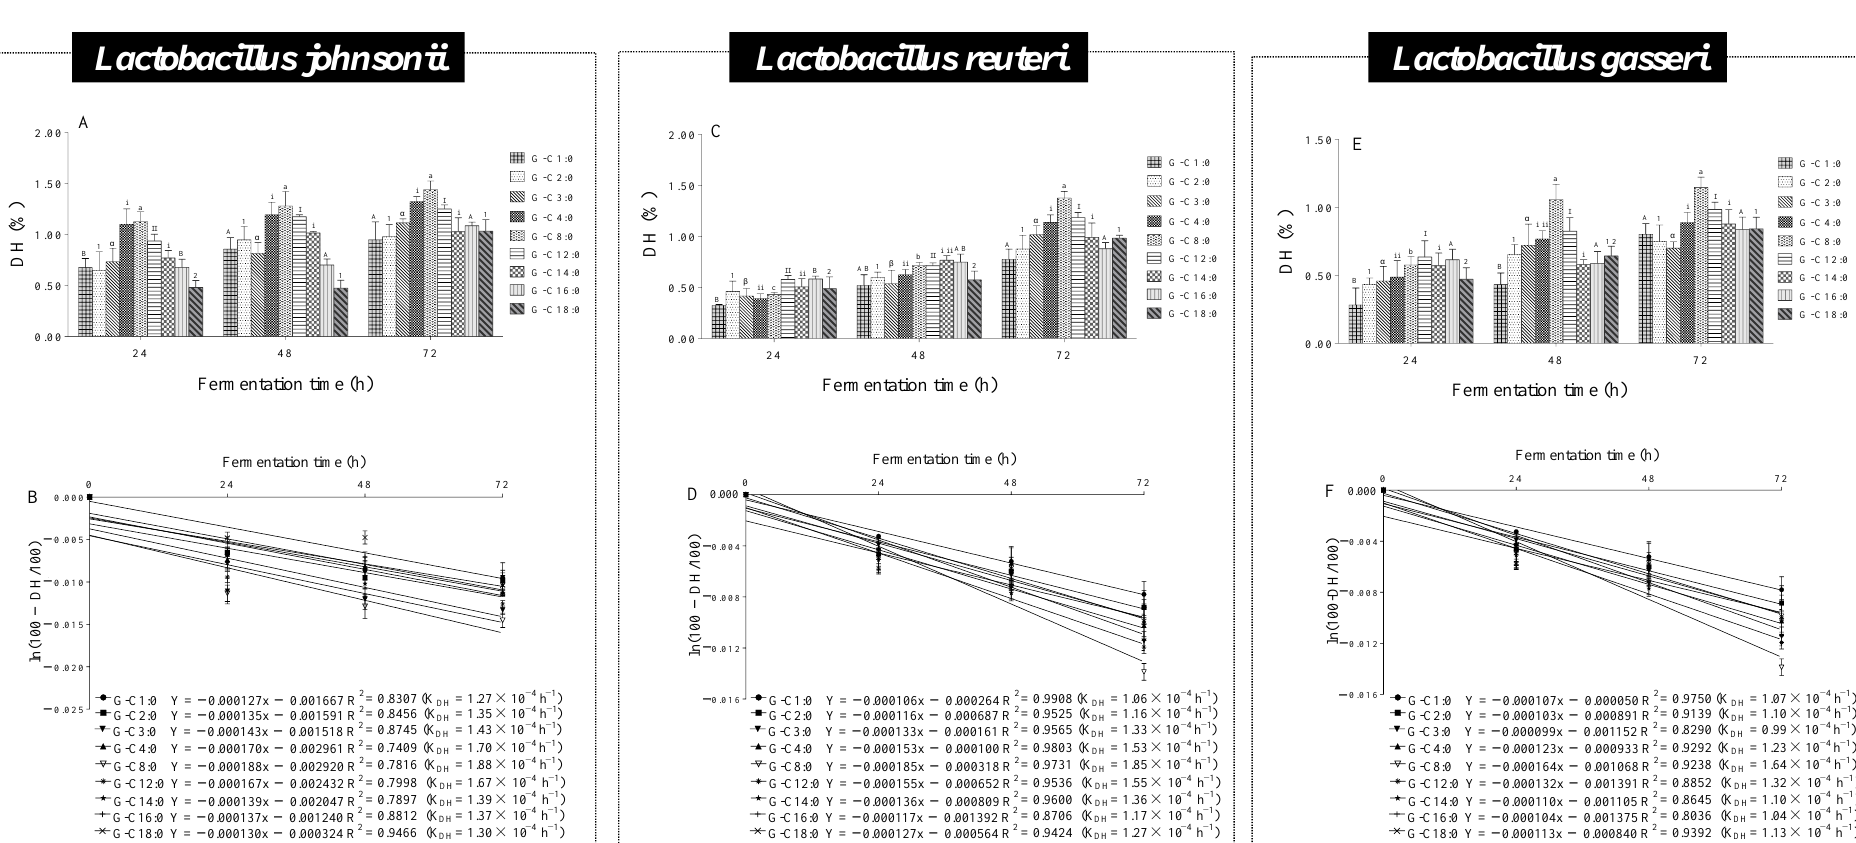
Figure 6. DHs ( A , C , E ) and kinetic models ( B , D , F ) of GA liberated from G-C4:0 and G-C14:0 by Lactobacillus johnsonii , Lactobacillus reuteri and Lactobacillus gasseri . Bars with different letters (A – B, a – c , α–β, ⅰ – ⅱ , Ⅰ – Ⅱ , 1 – 2) are statistically differen t ( p < 0.05).